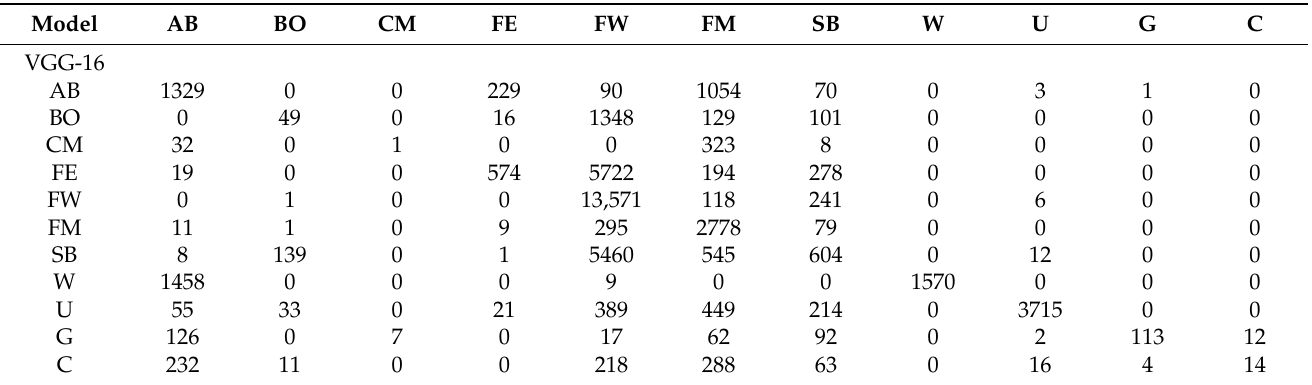
Table 4. Confusion matrix of the VGG-16 (AB = Aquatic bed, BO = Bog, CM = Coastal marsh, FE = Fen, FM = Freshwater marsh, FW = Forested wetland, SB = Shrub wetland, W = Water, U = Urban, G = Grass, C = Crop).